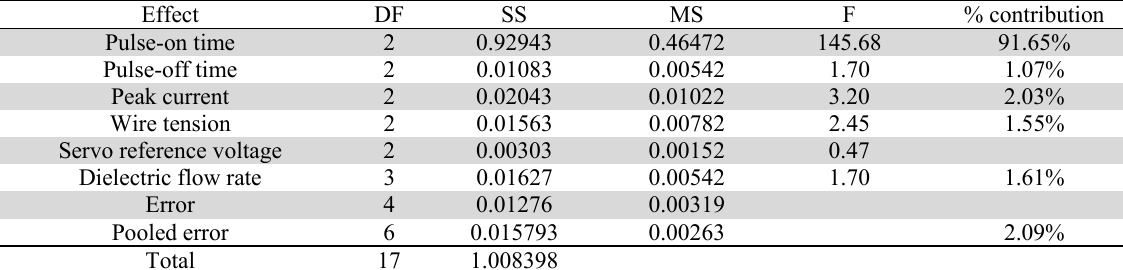
ANOVA results for Ra value in WEDM